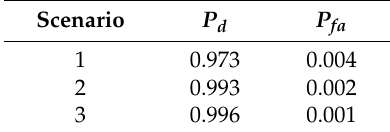
Table 1. P d and P fa of GBD in each scenario.